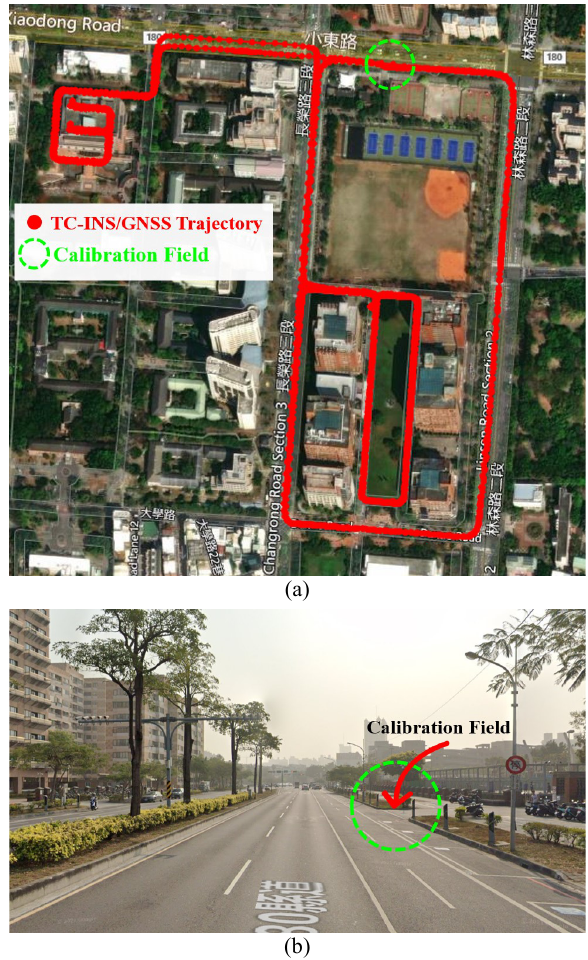
Figure 4 . The experimental area: (a) bird’s eye view of the INS/GNSS trajectory and calibration field, (b) real world environment of calibration field.